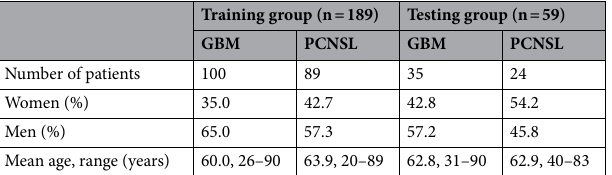
Table 1. Summary statistics of the study population. The total number of patients n = 320. GBM glioblastoma, PCNSL primary central nervous system